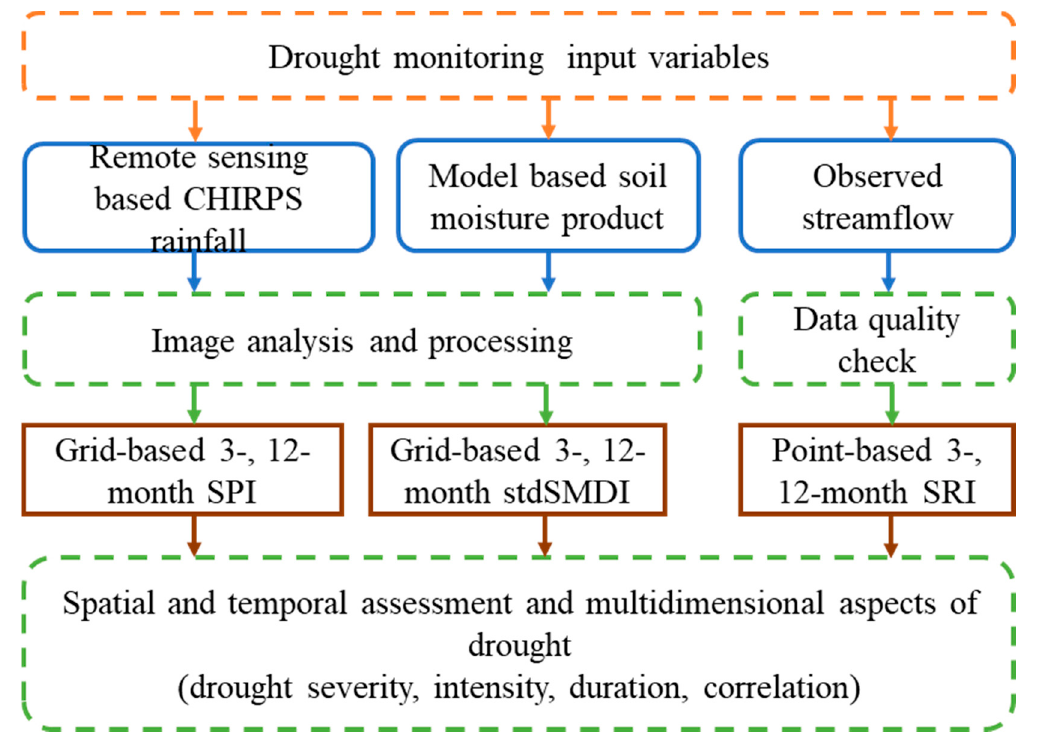
Figure 2. The flow chart that shows the steps followed in this study. The Pearson correlation coefficient values were generated for each pixel using the gridded time series of SPI and SMDI both at annual and seasonal time scales. In addition, the point-based SRI is correlated with the areal average SPI and SMDI to assess any concurrent events among each drought index. Equation 4 is used to calculate the Pearson correlation coefficient value, which measures the goodness of fit and linear association between the drought indices. It measures how well the drought indices correspond to each other. In this study, the simple linear association between the drought indices was explored at grid and point based using equation 4.